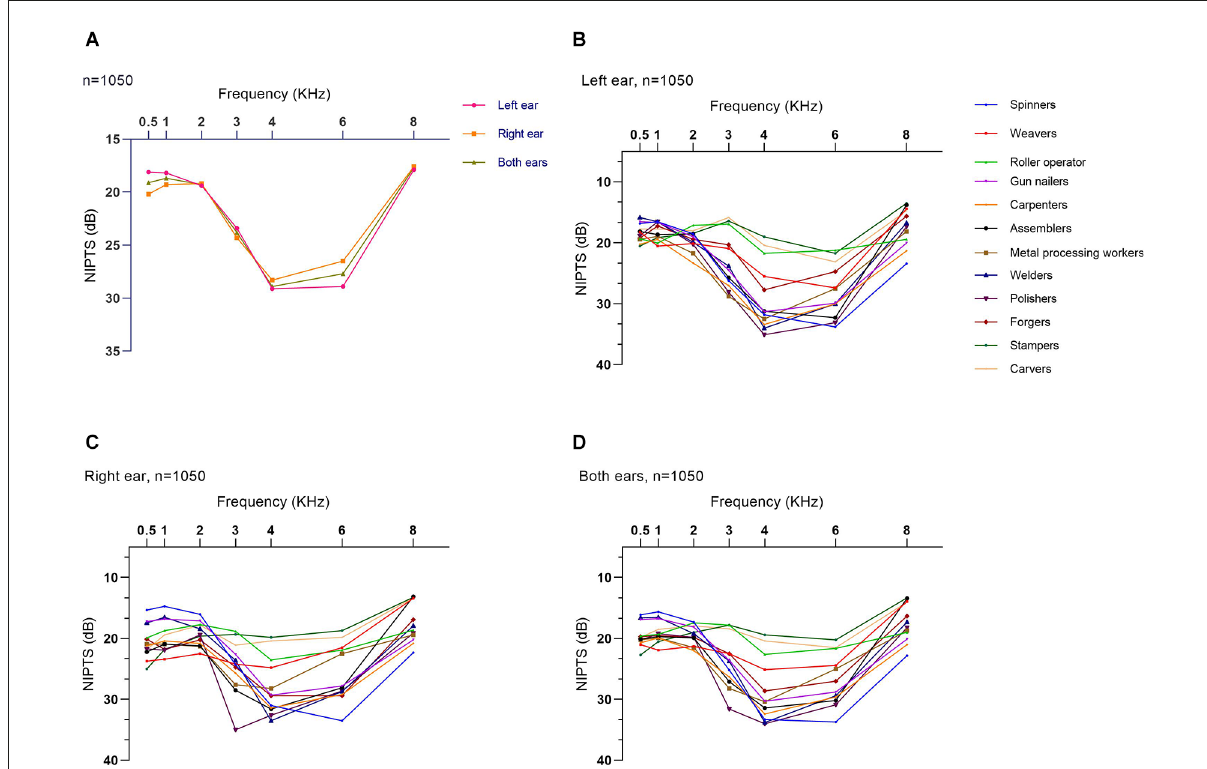
FIGURE3 Symmetrical and notching shape of average NIPTS curves for manufacturing workers. (A) Average NIPTS curves of the left ear, right ear, and both ears of manufacturing workers. (B) Average NIPTS curves of the left ears of different types of work. (C) Average NIPTS curves of the right ears of different types of work. (D) Average NIPTS curves of both ears of different types of